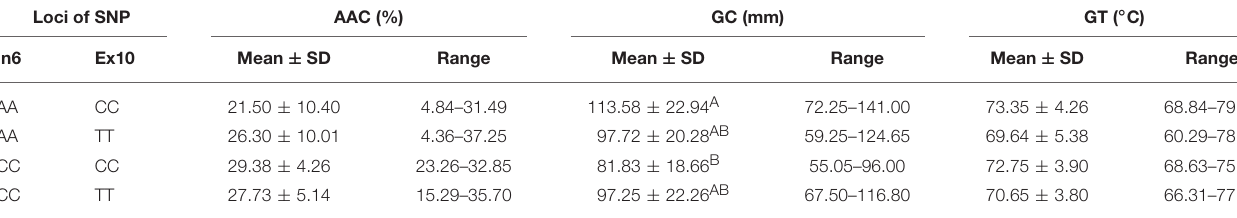
TABLE 6 | ECQs for different haplotypes of Ex6A/C and Ex10C/T polymorphisms of Wx . Loci of SNP